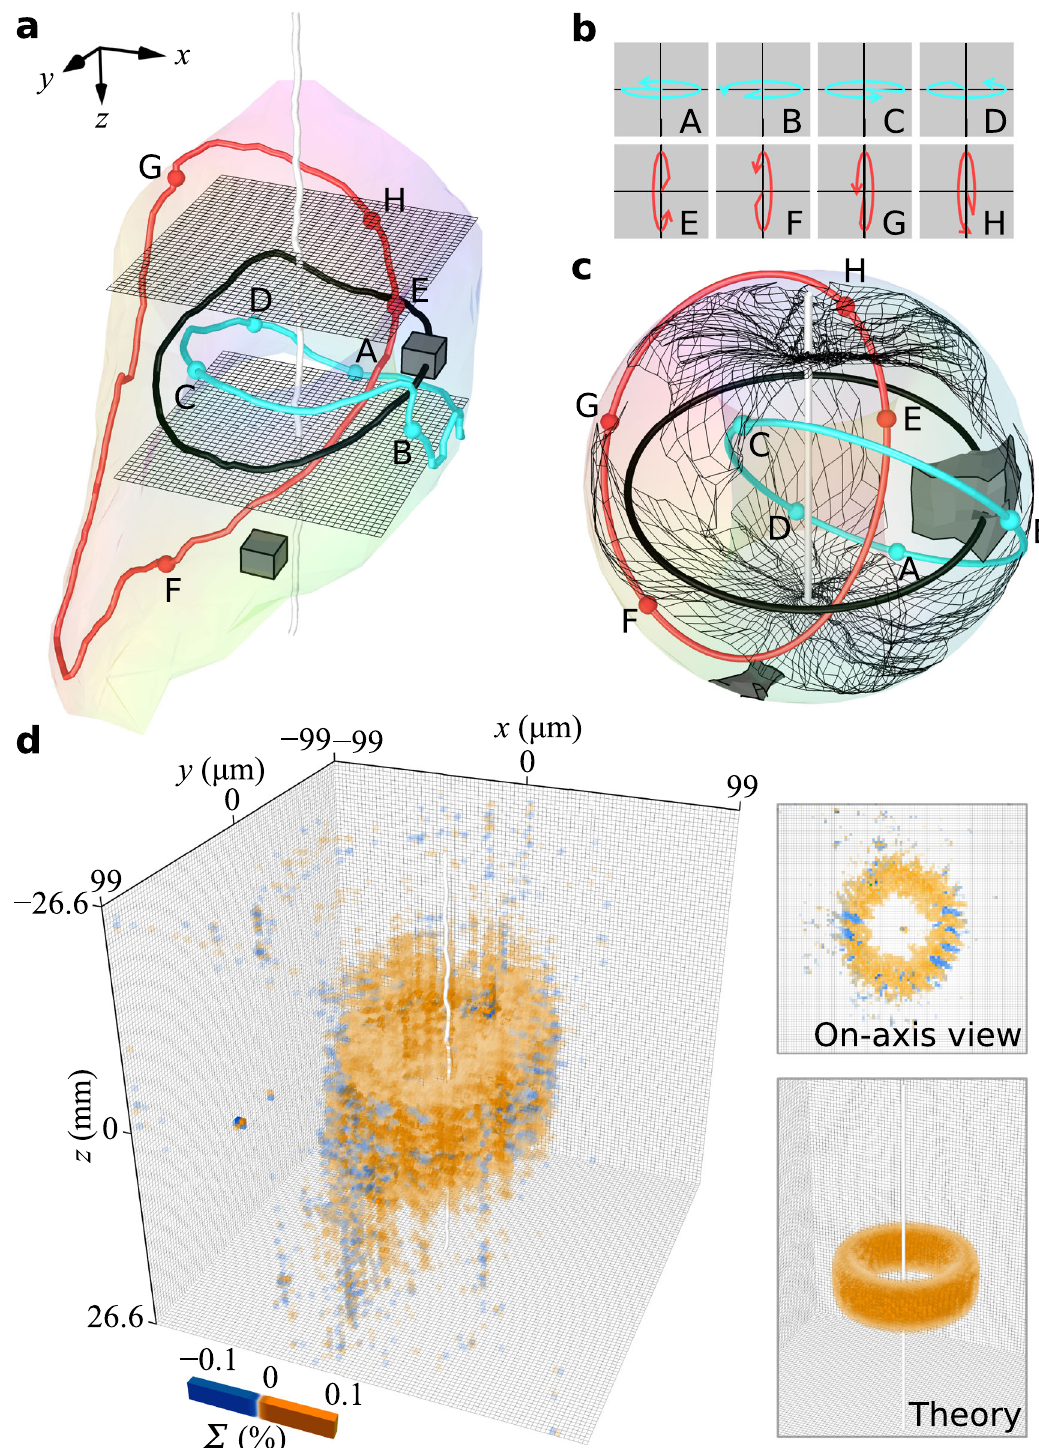
Fig. 4 Measured Skyrme density and optical hypersphere. The experimental polarisation hop fi on is shown ( a ), with measured phases ( b ) around the two fi laments shown ( α ¼ 0 ; π , S : 398, as in Fig. 3b). The hop fi on in real space closely resembles the structure of the optical hypersphere parameter space in ( c ), 3 ¼ 0 shown in volume-preserving projection from the RH circular polarisation state at the focal point of real space. Several features make the nature of the topological mapping clear. The real-space fi laments of constant polarisation are mapped to the smooth Hopf circles of fi xed polarisation in the optical hypersphere. The images of two typical real space transverse planes (grey grids) are distorted in the parameter space. The cube in real space intersecting the LH C line (black loop) maps to a larger distorted cuboid, indicating a greater Skyrme density Σ near this point. The cube away from the loop maps to a smaller cuboid, indicating a smaller Σ . In ( d ), the bounding cube represents the investigated focal volume in real space. The positive Skyrme density Σ of our structured skyrmionic hop fi on is concentrated around the LH C line with some positive and negative fl uctuations visible around it. The upper inset shows the on-axis view (from z ¼ þ1 ) of the toroidal conformation. The measured Skyrme number, given by the sum of the cubes volume, is 0.942 (described in “ Methods ” ). Theoretical predictions of the Skyrme density for the model fi eld are shown in the lower inset, giving a Skyrme number of 0.997 (calculations in Supplementary Note 4). NATURE COMMUNICATIONS| (2021) 12:6785